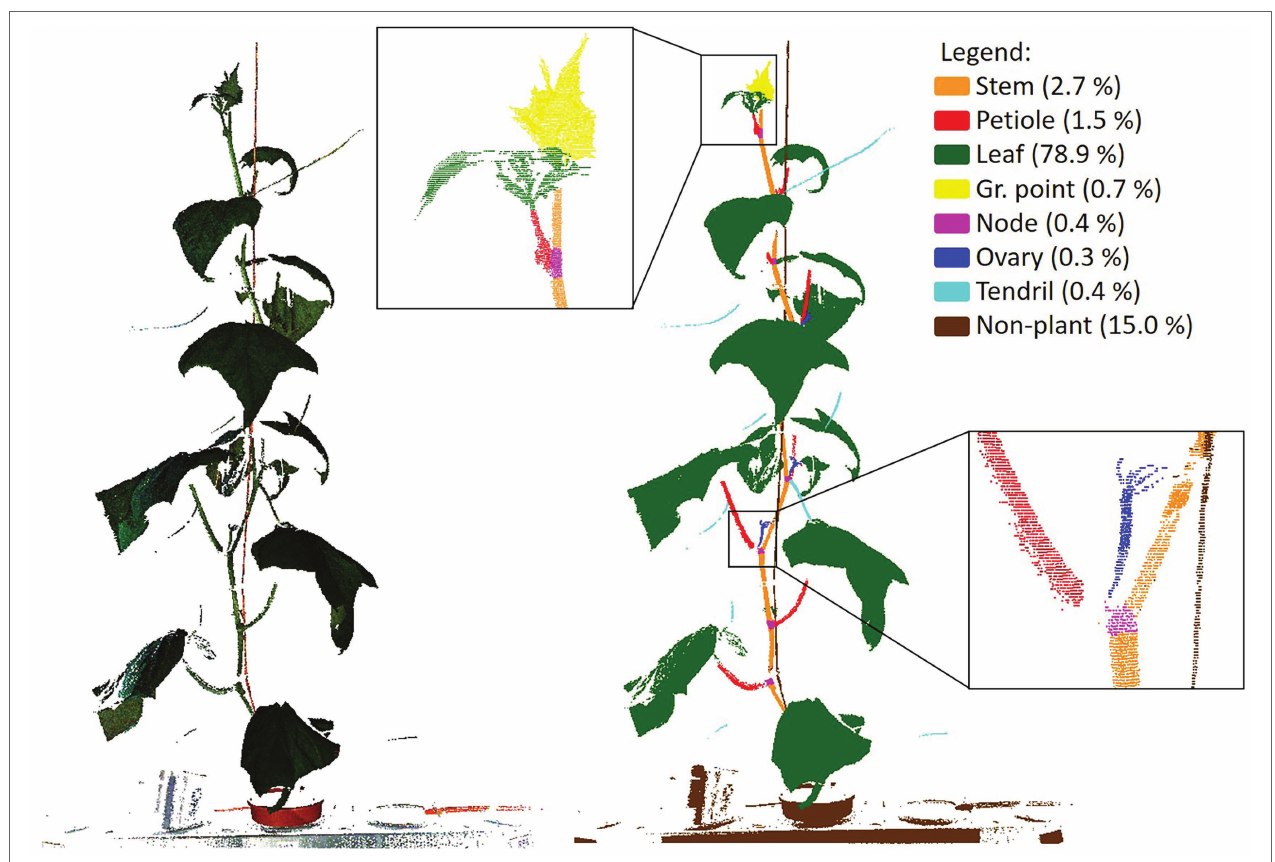
FIGURE 3 | Example of an original, coloured, point cloud (left) and a manually segmented point cloud showing the 8 classes used in this research. In the legend, the fraction of points per class is given. The black squares show a zoomed in segment of the segmented point